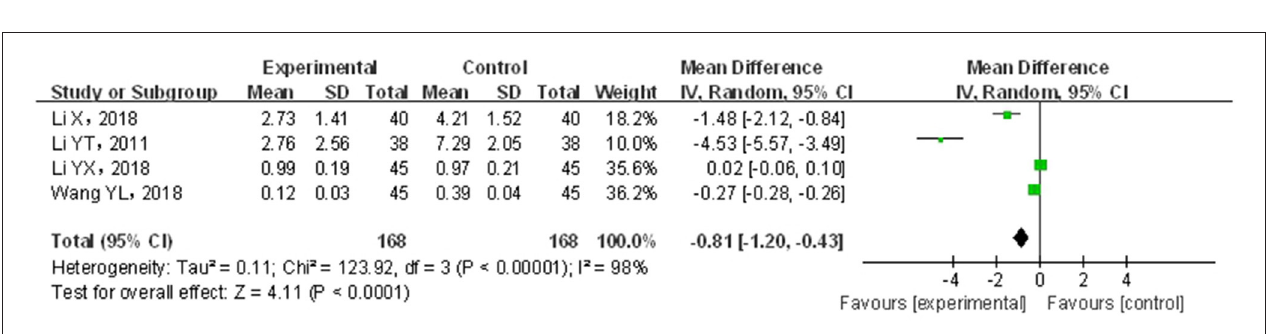
FIGURE 8 | Meta-analysis of infant massage and drug therapy in the treatment of children with functional constipation to reduce constipation symptom score.